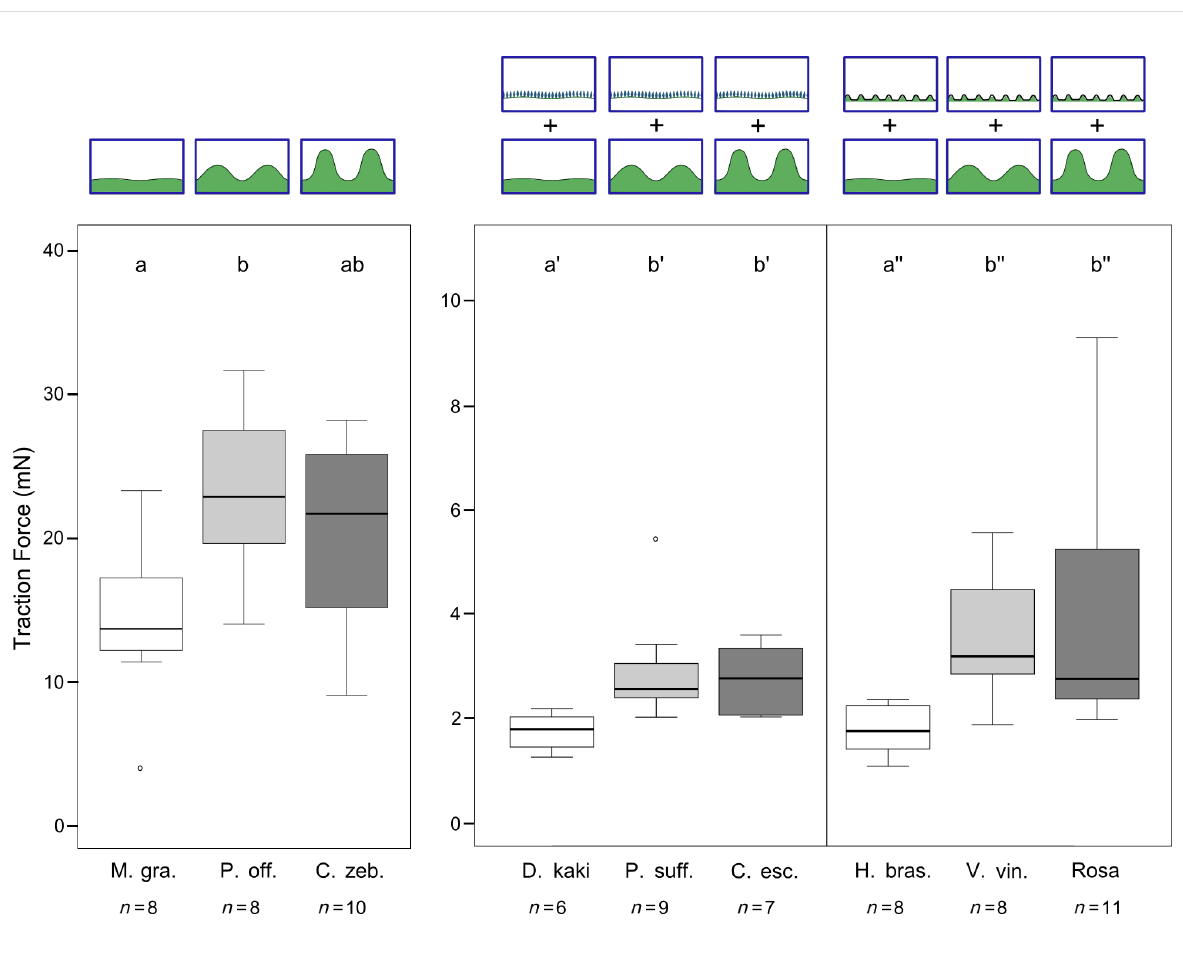
Figure 2: Traction forces of actively walking male Leptinotarsa decemlineata beetles on plant surfaces of different structure, both on the cellular level and on the level of superimposed microstructuring. Significant differences in traction force between tabular, convex and papillate epidermal cells are indicated by lower case letters. M. gra: Magnolia grandiflora; P. off: Paeonia officinalis; C. zeb.: Calathea zebrina, D. kaki: Diospyros kaki, P. suff.: Paeonia suffruticosa , C. esc.: Colocasia esculenta , H. bras.: Hevea brasiliensis , V. vin.: Vitis vinifera , Rosa: Rosa hybrid Floribunda cv.